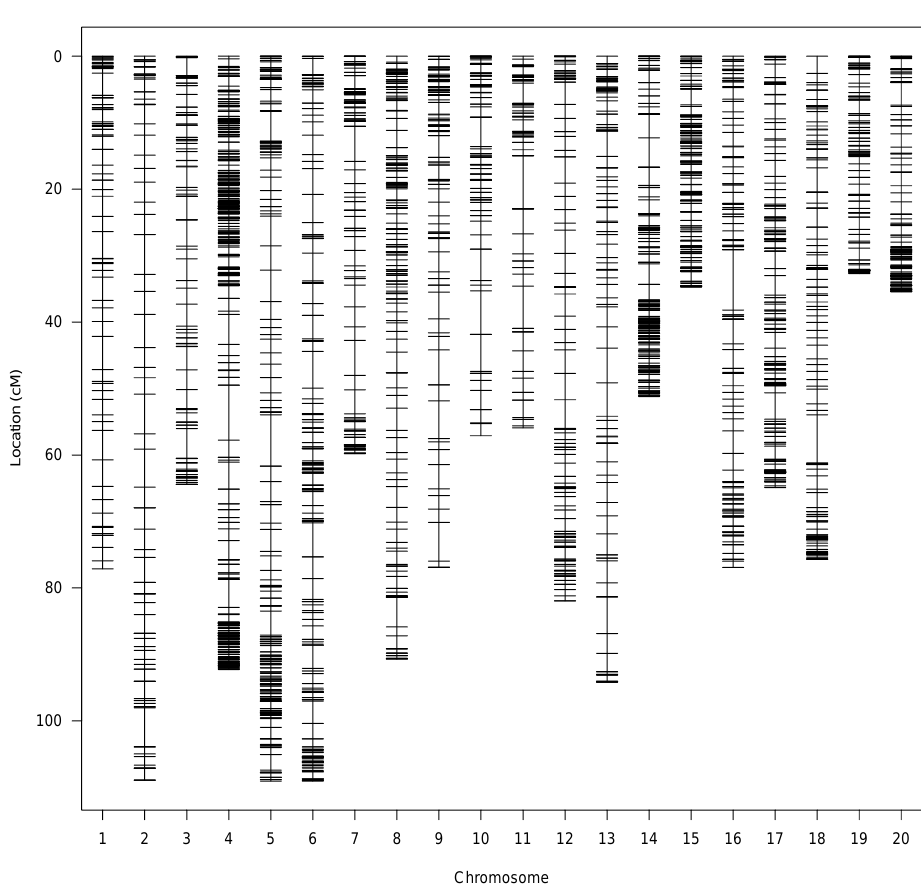
Figure 1. Genetic linkage map showing the SNP distribution across the 20 yam chromosomes. Each vertical line represents a yam chromosome with genetic distance in Kosambi units (cM). Table 2. Distribution of SNP markers and linkage group length (cM) in each chromosome.